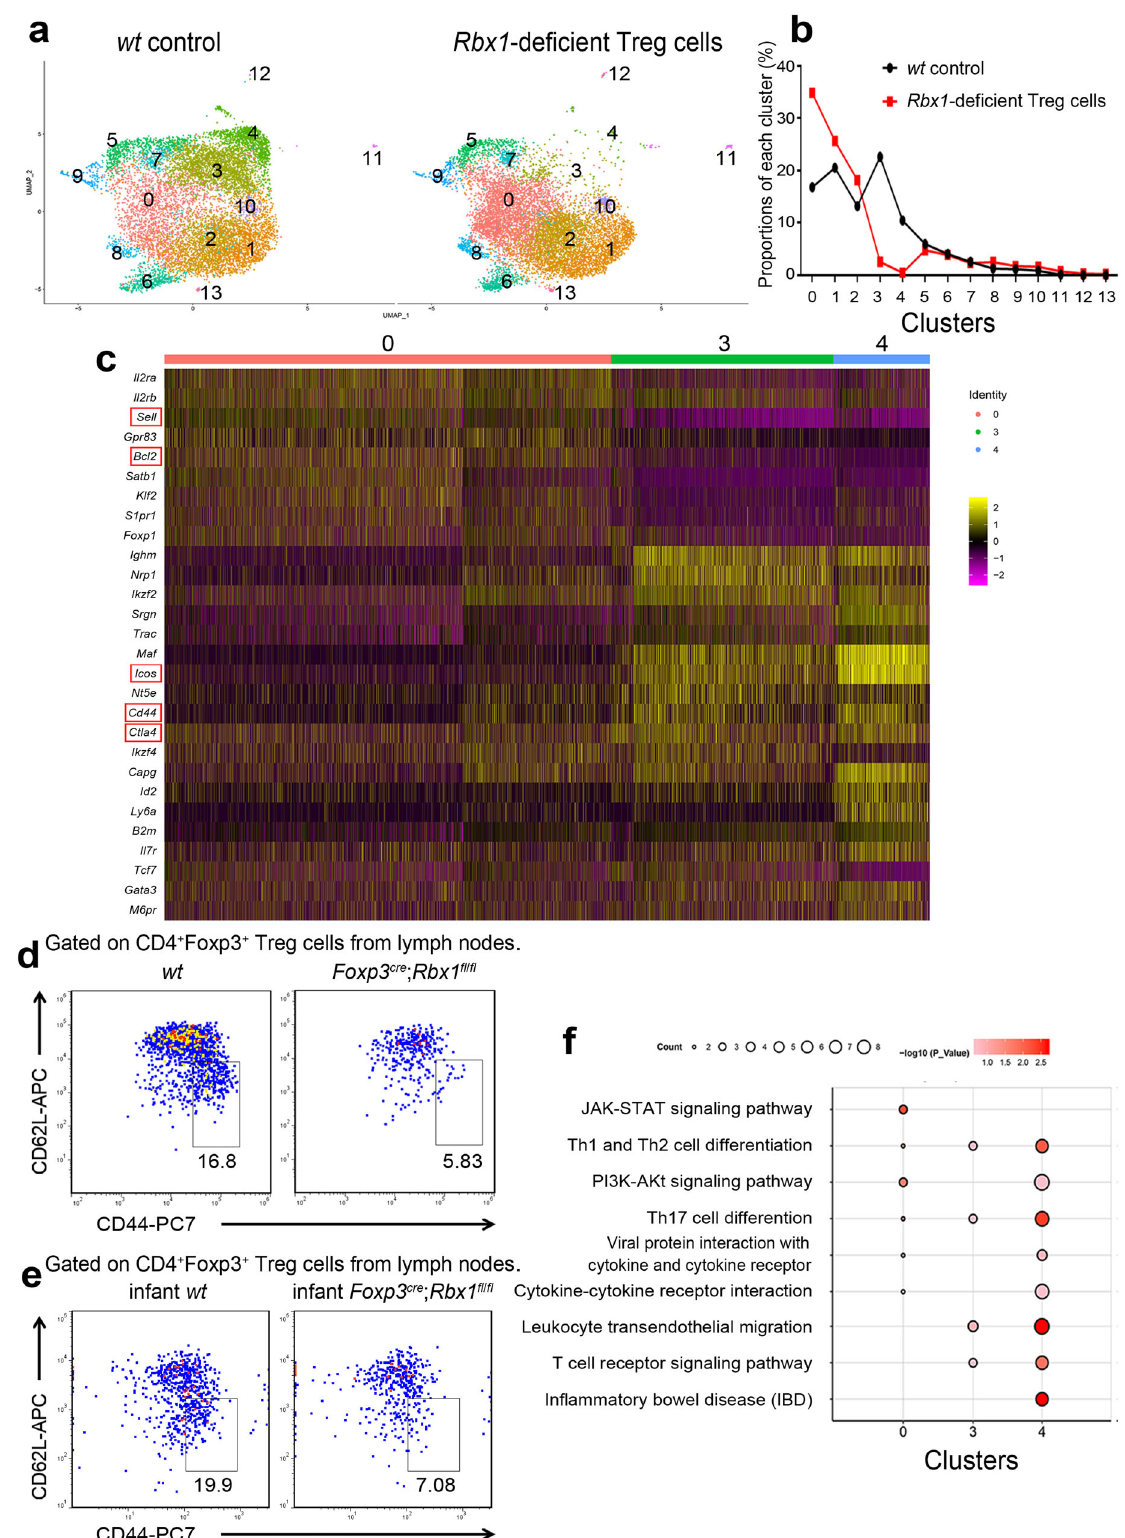
Fig. 3 Single-cell transcriptomics of wt and Rbx1 -de fi cient Treg cells. a Two-dimensional UMAP visualization of single cell transcriptomics data in CD4 + YFP + Treg cells from peripheral lymph nodes of female Foxp3 cre / wt and Foxp3 cre / wt ; Rbx1 fl / fl mice (10 weeks old). b Proportions of each cluster in CD4 + YFP + Treg cells in peripheral lymph nodes from female Foxp3 cre / wt and Foxp3 cre / wt ; Rbx1 fl / fl mice (10 weeks old). c Heat map of selected marker genes in clusters 0, 3, and 4. Single cells were represented by vertical lines and different colors re fl ected the relative abundance of indicated genes. d Expression of CD44 and CD62L in Treg cells from peripheral lymph nodes of wt and Foxp3 cre ; Rbx1 fl / fl mice (p20, male). e Expression of CD44 and CD62L in Treg cells from peripheral lymph nodes of wt and Foxp3 cre ; Rbx1 fl / fl infant mice (p8, male). f Selected pathways of clusters 0, 3, and 4 in the KEGG analysis. Source data are provided as a Source Data fi